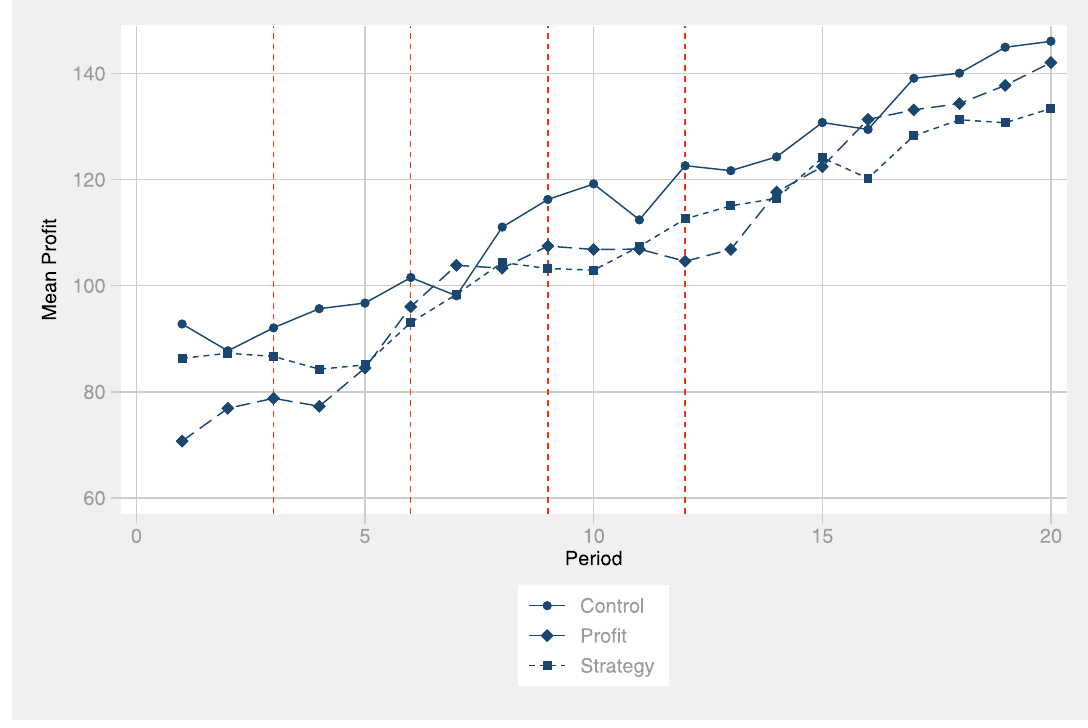
Fig 2. Evolution of profits over time. The figure reports the average profit by the experimental group for each of the 20